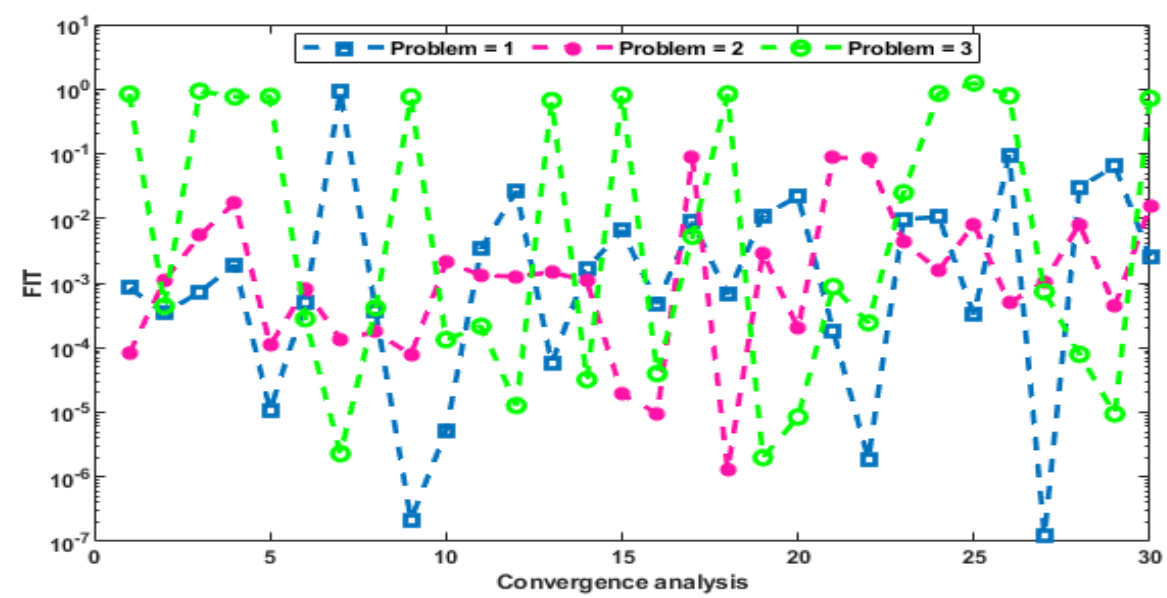
Figure 4. Convergence performance of FIT for each problem of the HO-NSDM.